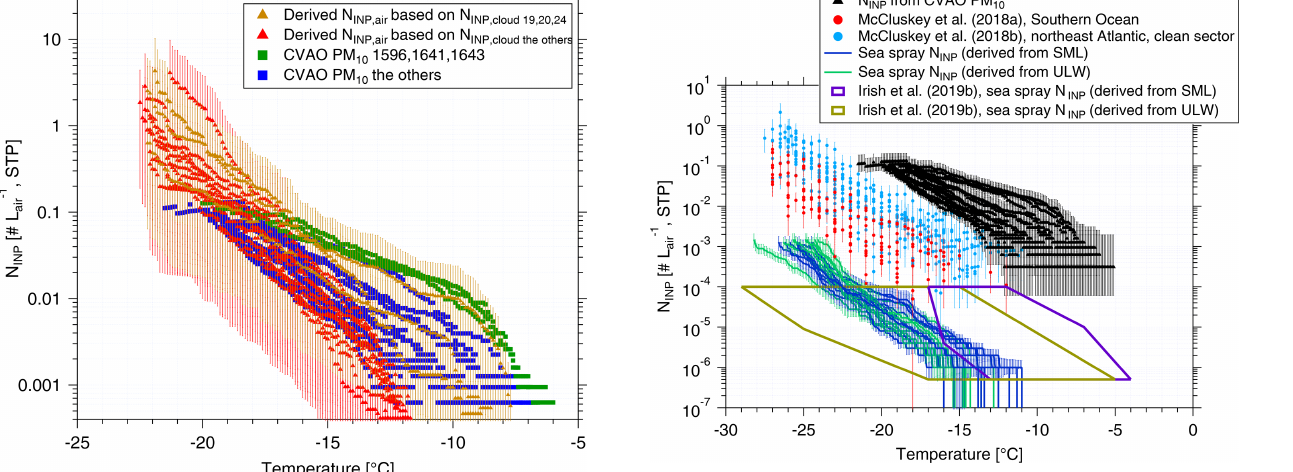
Figure 7. The measured atmospheric N INP values as a function of ice-nucleation temperature are shown as squares. The derived N INP in the air ( N INP,air ) based on INP concentrations measured for cloud water are shown as triangles. The samples with highly ice active INPs at warm temperatures are shown in a different color than the others: CVAO 1596, CVAO 1641 and CVAO 1643 are shown as green squares and derived N INP,air based on Cloud 19, Cloud 20 and Cloud 24 are shown as brown triangles. The uncertainty range indicated for the derived N INP,air originates from calculations with 7 and 20µm cloud droplet size.